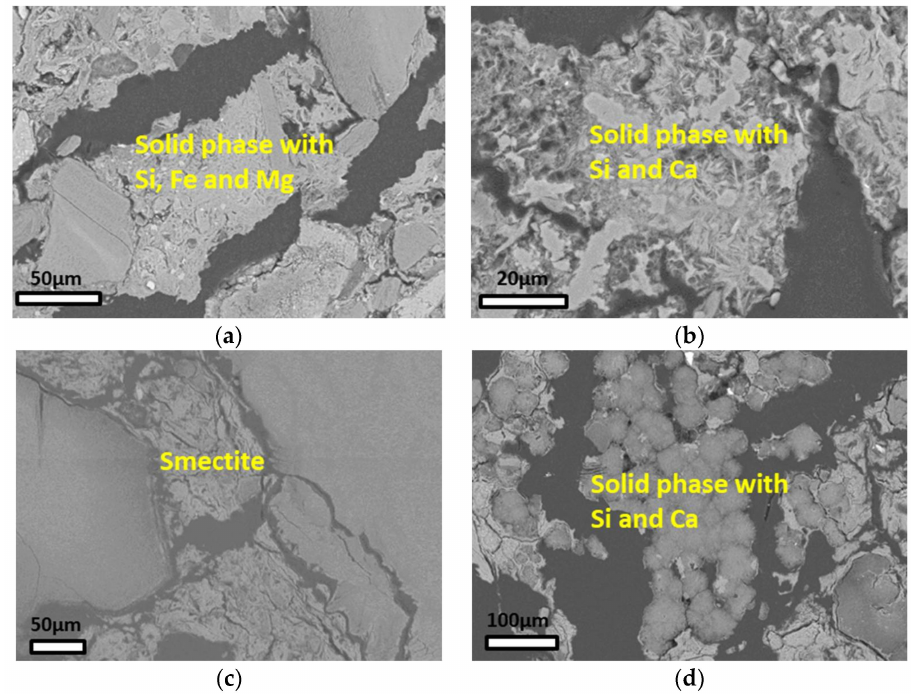
Figure 6. Minerals in the matrix of the clastic sediments from DH4 at different depths: ( a ) Solid phase with Si, Fe, and Mg at 3 m; ( b ) Solid phase with Si and Ca at 3 m; ( c ) Smectite at 6 m; ( d ) Solid phase with Si and Ca at 6